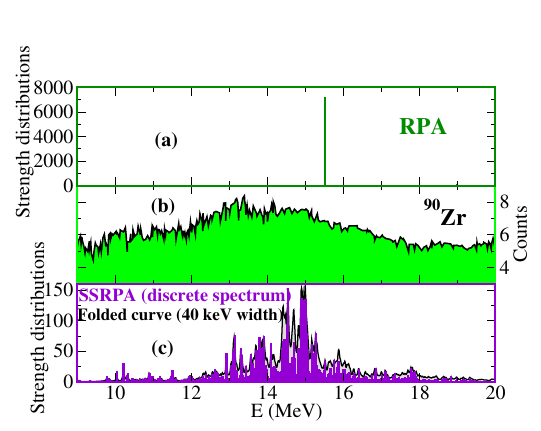
Figure 6. (a) RPA strength distributions, (b) Experimental spec- trum [23] and (c) SSRPA strength distributions for the isoscalar GQR for 90 Zr. For the cases of the RPA and SSRPA discrete spectra, units are e 2 fm 4 . For the SSRPA folded case, units are e 2 fm 4 MeV − 1